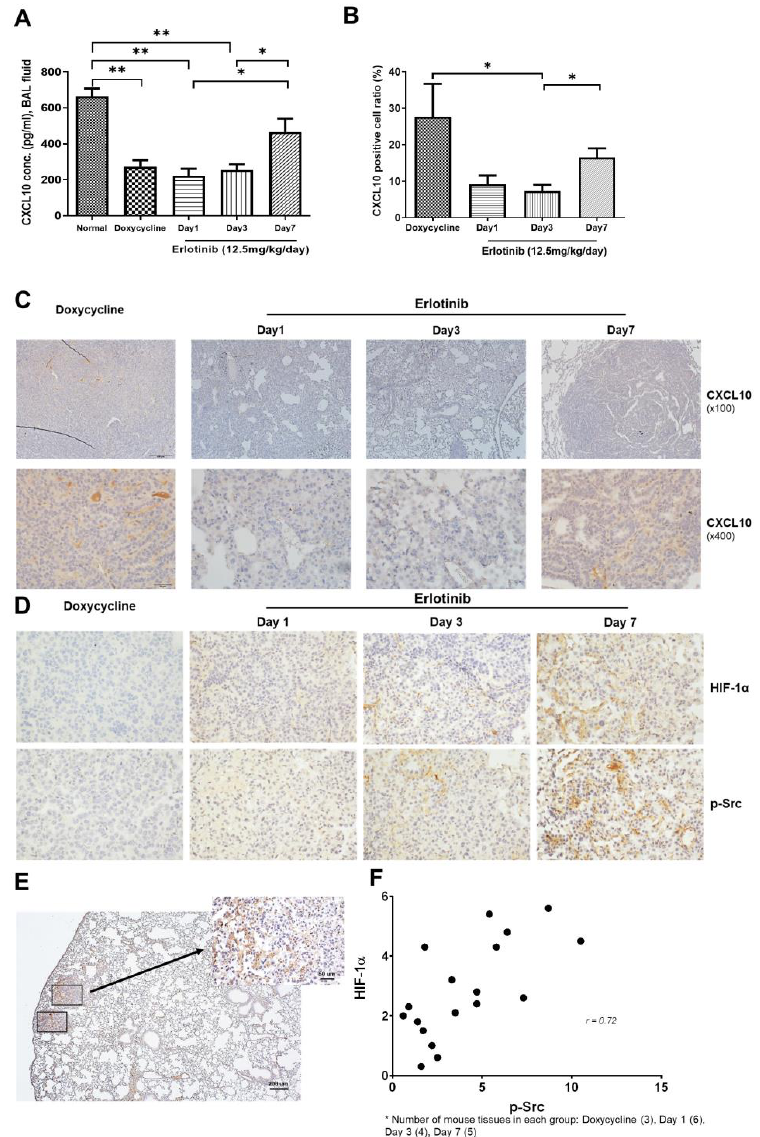
Figure 5. Effects of CXCL10/CXCR3 – Src pathway activation by TKIs in a transgenic mouse model of EGFR-mutant lung cancer. TetO – EGFRL858R transgenic mice were fed 200 mg/kg of doxycy-